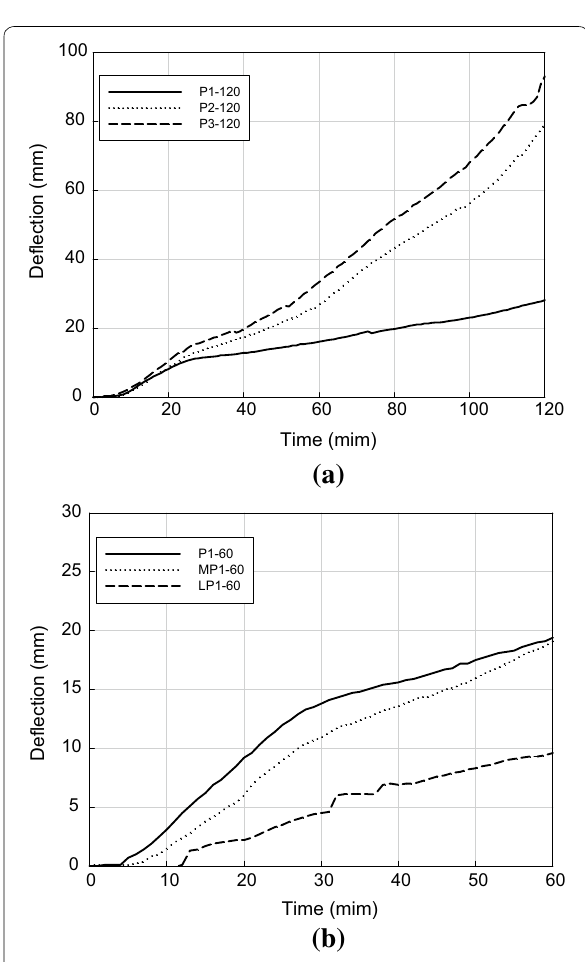
Fig. 11 Deflections of specimens during fire tests. a Compared with different load level and b compared with different cross-sectional